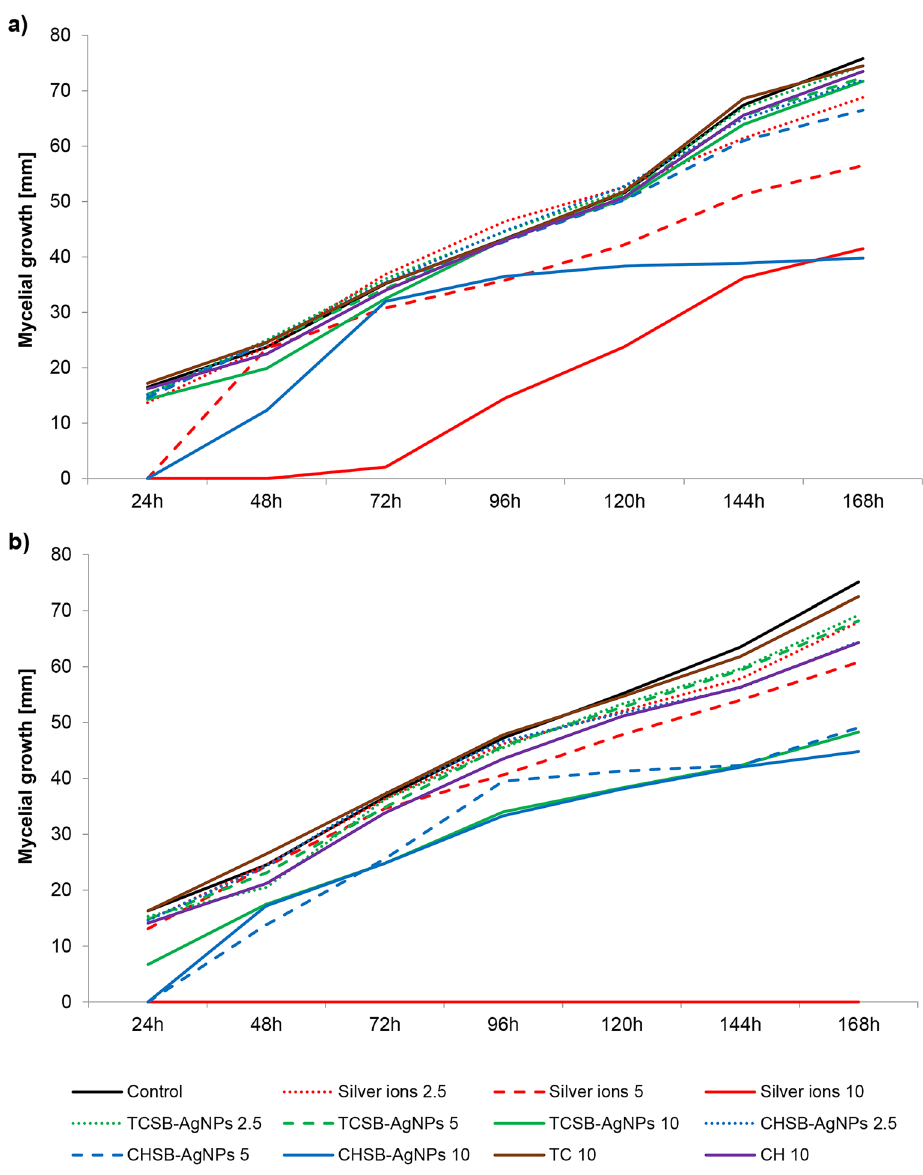
Figure 2. The impact of silver ions, AgNPs and stabilizing agents on the mycelial growth of F. equiseti over 24 h ( a ) and 240 h ( b ) of the exposure period. The number given for each treatment represents the concentration expressed in mg L −1